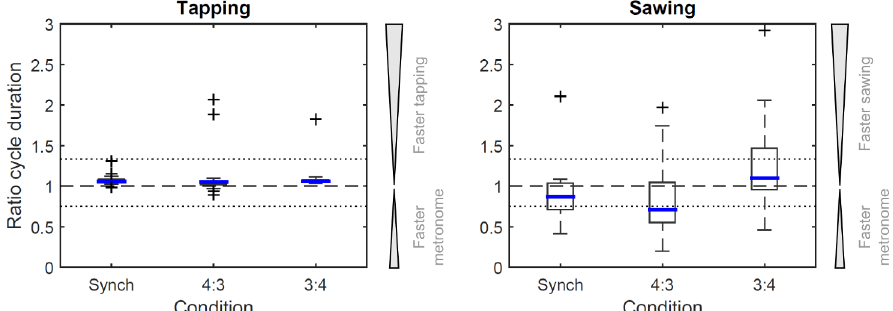
Fig 3. Boxplots for the ratios of the set metronome beat to tapping cycle duration (left) and sawing cycle duration (right) calculated for the three dual movement tasks where a metronome beat was matched through tapping. For experimental conditions and legend, please refer to Fig 2. The three large outliersfor tappingrepresent participants tappingat aroundtwice the set metronomebeat, which was confirmedby video